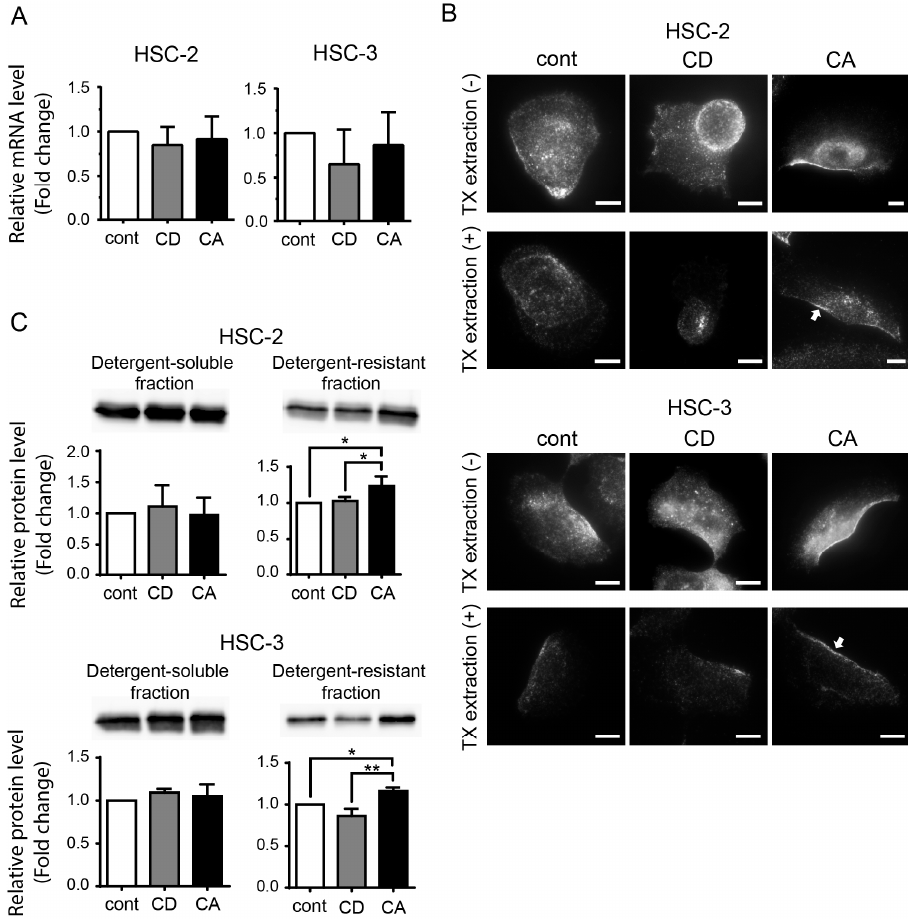
Figure 4. Cholesterol manipulation changes the CAV1 protein level in the cold Triton X-100 (TX)- resistant lipid raft region. ( A ) Quantitative RT-PCR for CAV1. Triplicate results are shown as mean ± SD. ( B ) Immunofluorescence staining for CAV1 in cells with or without TX pre-extraction in HSC-2 (upper) and HSC-3 (lower). Scale bars, 10 µm. Arrow indicates asymmetric membranous localization of CAV1 in TX pre-extracted cells. ( C ) CAV1 protein level in detergent-soluble fraction and detergent-resistant fraction in HSC-2 (upper) and HSC-3 (lower). Coomassie blue stain was used as the loading control. Bar graphs show triplicate results of relative protein level expressed as mean ± SD. * p < 0.05, ** p <